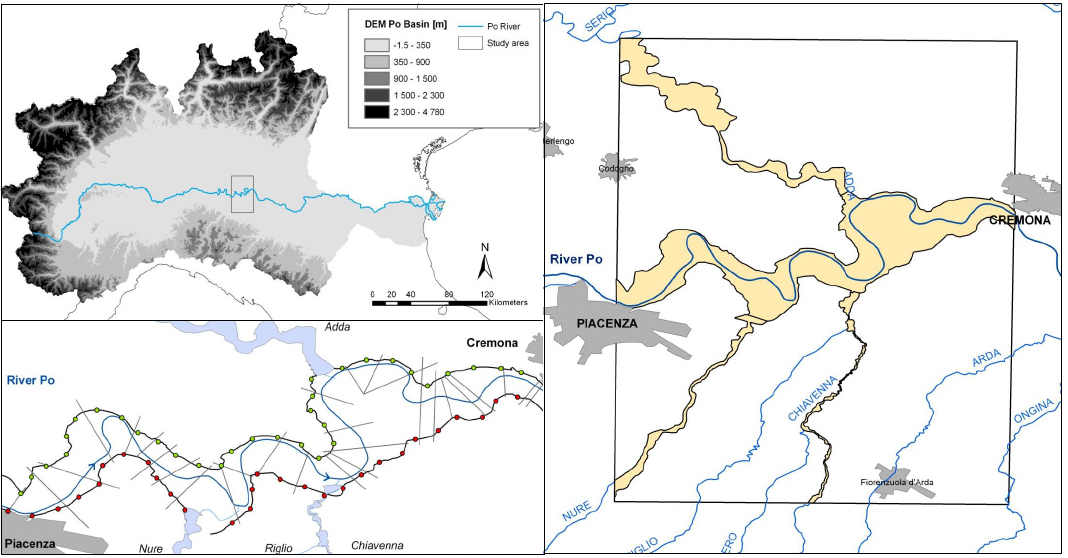
Fig. 1. Study area. Upper left panel: Po River basin and study area (box); lower left panel: river cross-sections (grey lines) and levee system discretization for the left (green dots) and right (red dots) side; right panel: 2-D raster-based model extension (grey box) and floodplain area